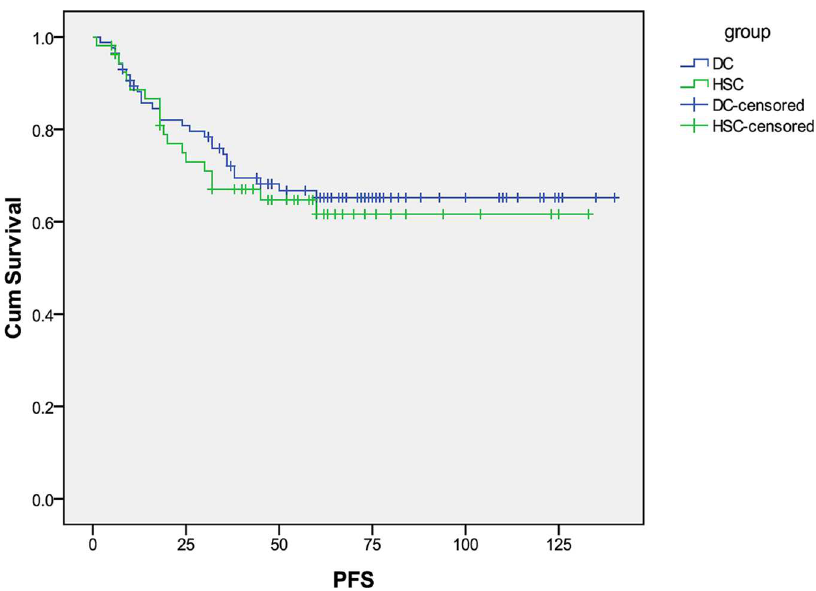
Fig 2. Progression-free survival in patients with type II endometrial cancer diagnosed with hysteroscopy (HSC) versus D&C.